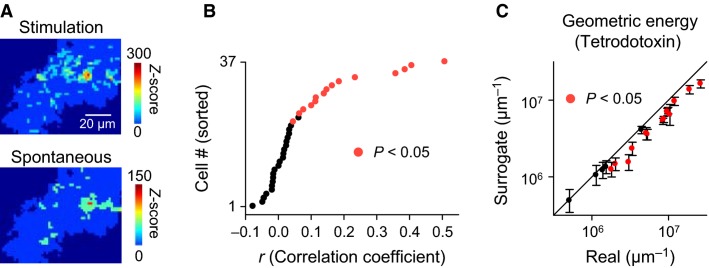
Visual responses resemble spontaneous activity patterns. (A), Representative Z-score maps in activated domains (Stimulation) and spontaneous domains (Spontaneous). (B), Spatial correlations of the Z scores in all pixels between Stimulation and Spontaneous conditions. Red dots indicate astrocytes with significantly high correlation coefficients (Pearson product–moment correlation coefficient test). (C), Same as Fig.6D, but for spontaneous domains that occurred in tetrodotoxin-treated visual cortex. n = 19 astrocytes.